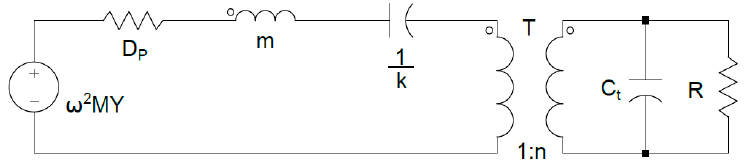
Figure 11. Equivalent circuit of an electrostatic force harvester.